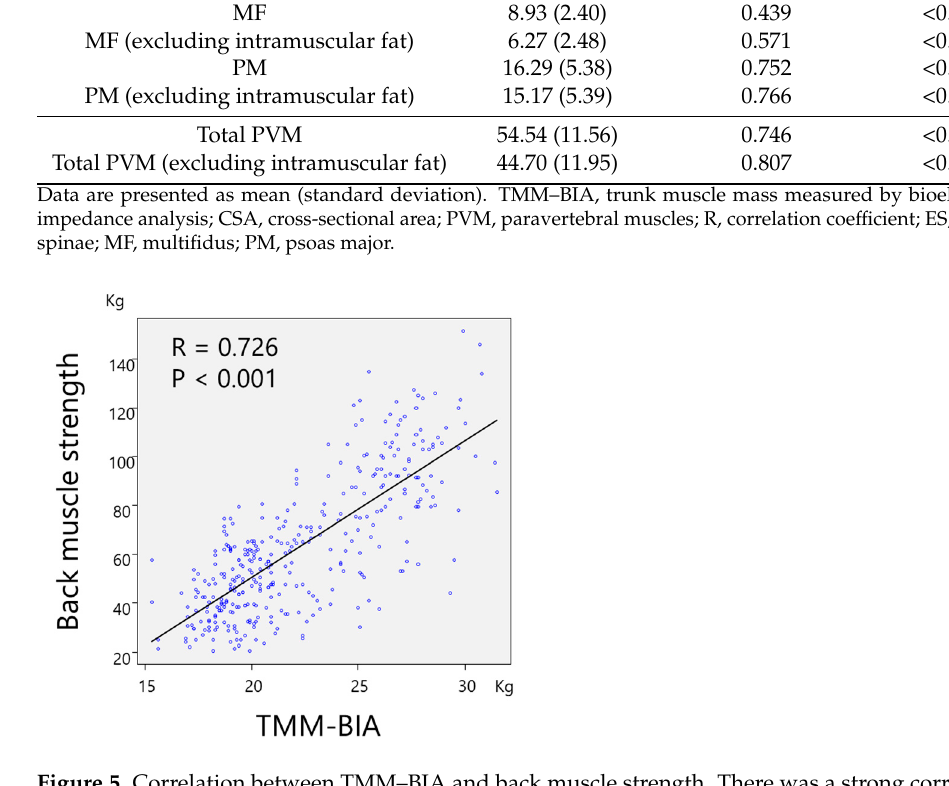
Figure 6. Case presentation 1. A 67-year-old male with no symptoms of low back pain had a CSA of PVM and fat-free PVM of 75.4 and 68.04 cm 2 , respectively. The fat-free percentage of PVM was 90.2%. CSA, cross-sectional area; PVM, paravertebral muscles.